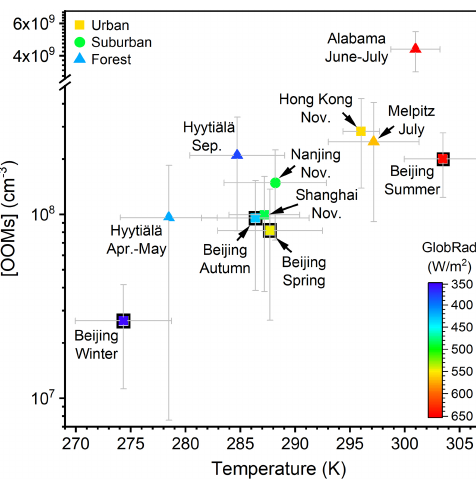
Figure 2. OOM concentration vs. temperature at various lower tro- pospheric sites during the daytime (07:00–17:00LT). Data points are colored by theoretical global radiation (GlobRad). Square, cir- cle, and triangle markers represent urban, suburban, and forest ar- eas, respectively. The gray error bars show standard deviations (1 σ ). Nanjing, Shanghai, and Hong Kong SAR datasets are from Nie et al. (2022), Melpitz data are from Mutzel et al. (2015), Alabama data are from Massoli et al. (2018), and Hyytiälä datasets are from Yan et al. (2016) and Zha et al.